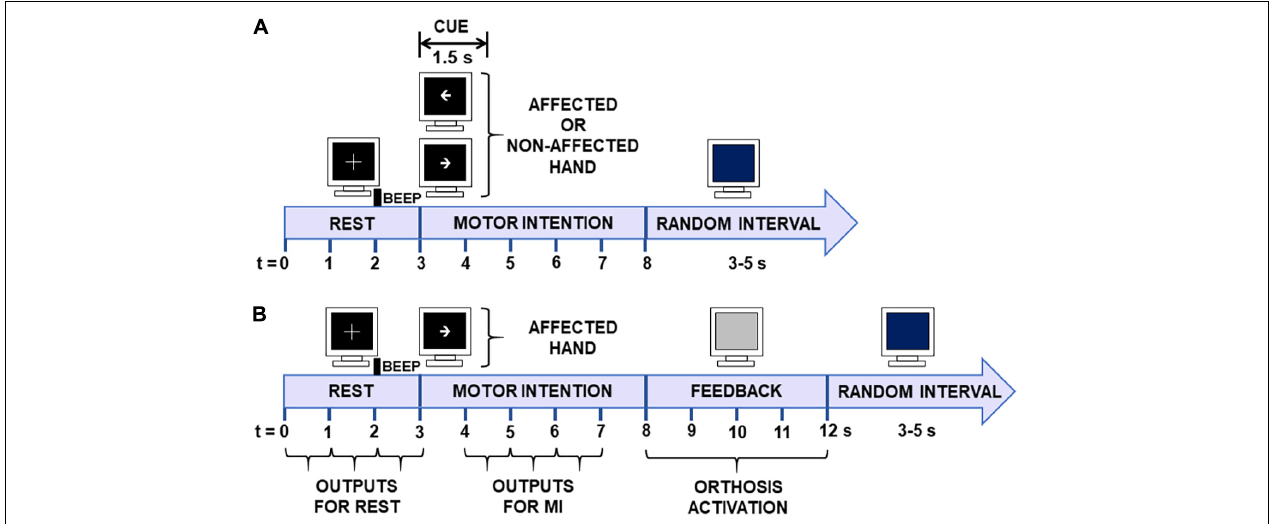
FIGURE 3 | Time diagrams of offline and online trials. (A) Baseline EEG recordings. During the first 3 s, patients rested with their eyes open (REST). From 3 to 4.5 s, an arrow signaled them to initiate MI with the affected or unaffected limb. MI was performed from 3 to 8 s. The data from REST (0–3 s) and MI (4–7 s) periods were used for posterior EEG analyses. (B) Online BCI trials. The first 3 s was used for classification of the REST condition, and from 4 to 7 s for MI of the affected limb.